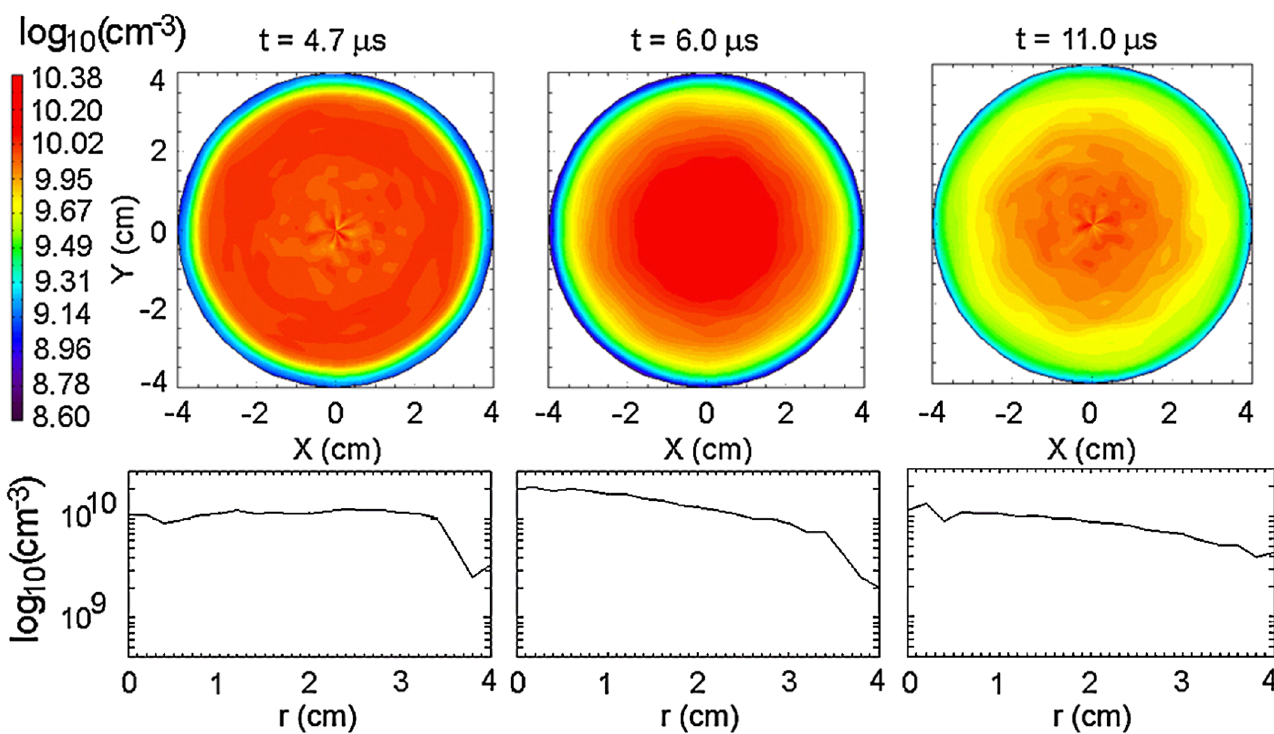
FIG. 11. (Color) n radial slices at (cid:3) (cid:6) (cid:2) (bottom) and f r; (cid:3) g isocontours (top) through the midplane of a ferroelectric ceramic p segment at t (cid:6) 4 : 7 (cid:1) s (left), t (cid:6) 6 (cid:1) s (center), and t (cid:6) 11 (cid:1) s (right). All plots are on the same log